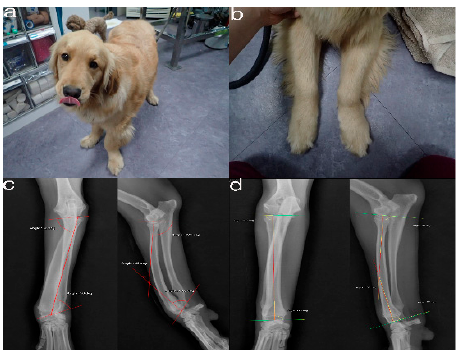
Figure 1. The images show the antebrachial growth deformity (AGD) ‐ affected (left leg) and contralateral unaffected ‐ antebrachium (right leg) with the joint ‐ orientation angles ( a , b ), and orthogonal radiographs ( c , d ).